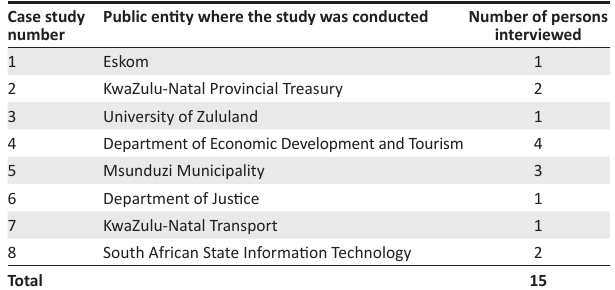
TABLE 1: List of public